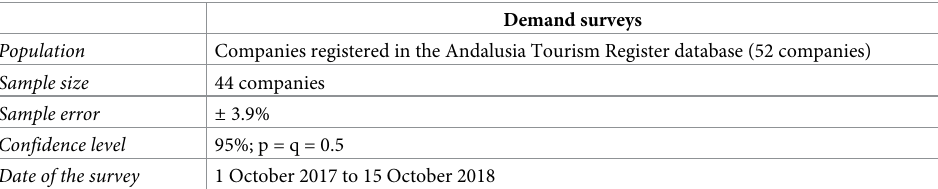
Table 1. Survey data